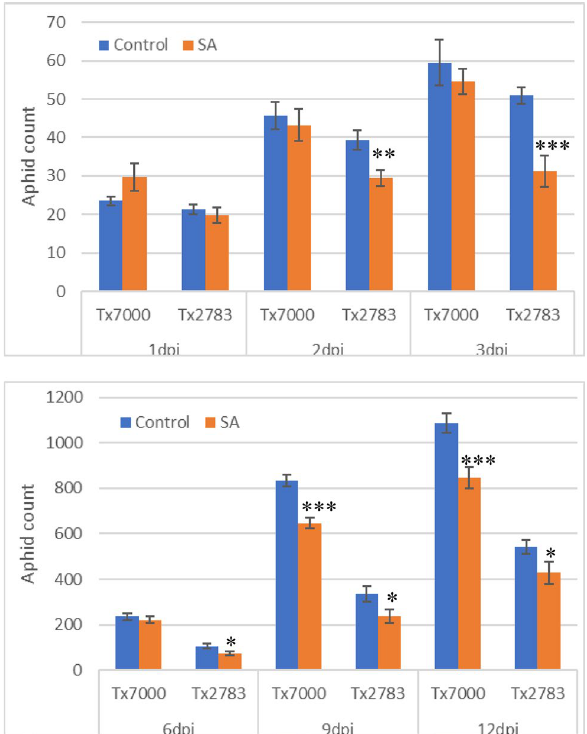
Figure 7. Aphid count in control and SA treated sorghum lines at 1-, 2-, 3-, 6-, 9- and 12-days post infestation of sugarcane aphid (SCA). Error bars represent standard error among replicates. The asterisks represent statistically significant changes between control and SA treated samples as determined using Student’s t-test (*, p ≤ 0.05; **, p ≤ 0.01; ***, p ≤